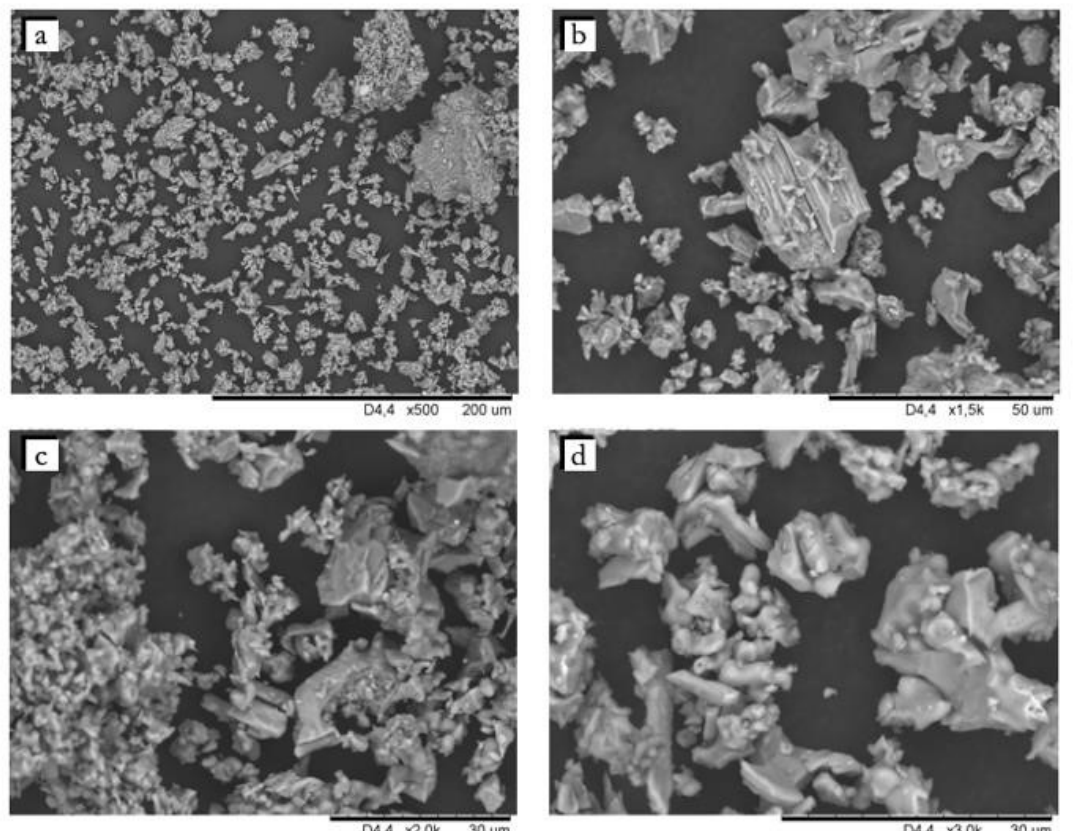
Figure 3. Tailing images obtained by SEM with different resolutions to observe the morphology of the material under study. (a) 500x resolution, (b) 1.5K resolution, (c) 2.0K resolution, and (d) resolution of 3.0K.